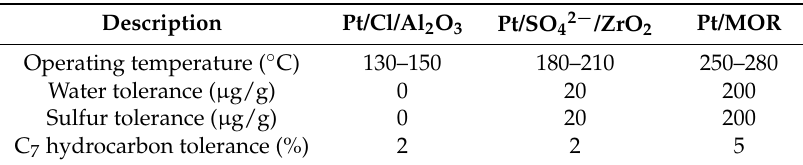
Table 3. Summary of commercial light naphtha hydroisomerisation